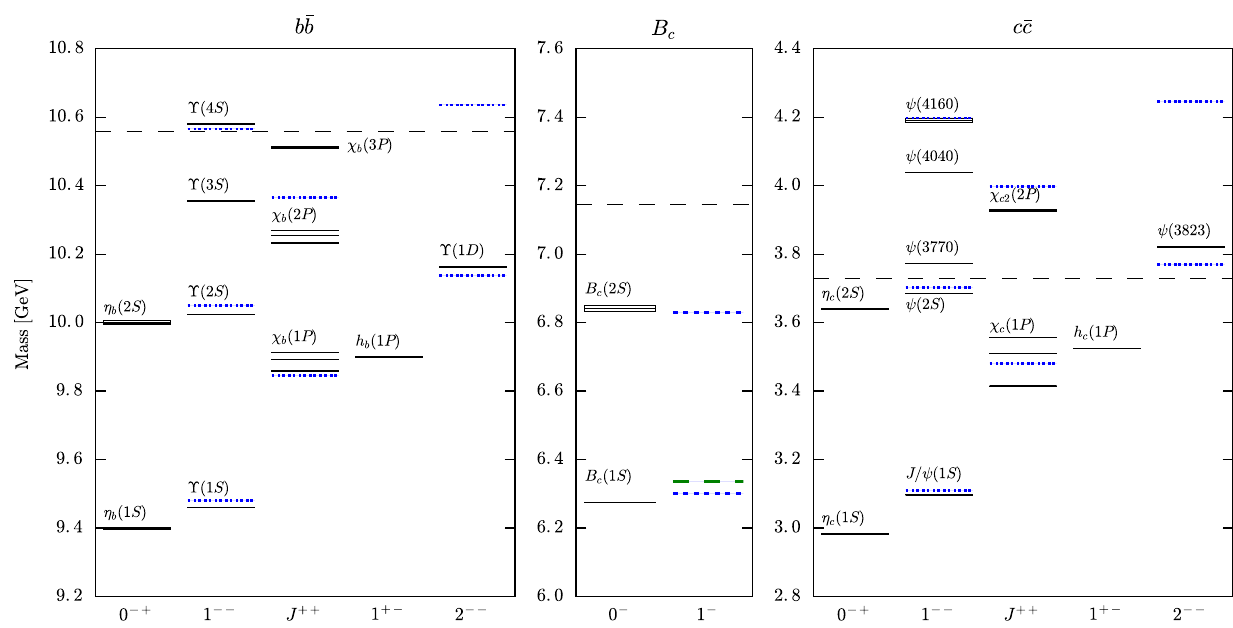
Fig. 3 Results of our fit to b ¯ b and c ¯ c low-mass states, are shown by dotted blue lines on the background of data for heavy quarkonia and B c mesons. The dashed green line represents an average of various predic- tionsfor B ∗ c mass[30].Dashedlinesacrossapanelrepresentthresholds.